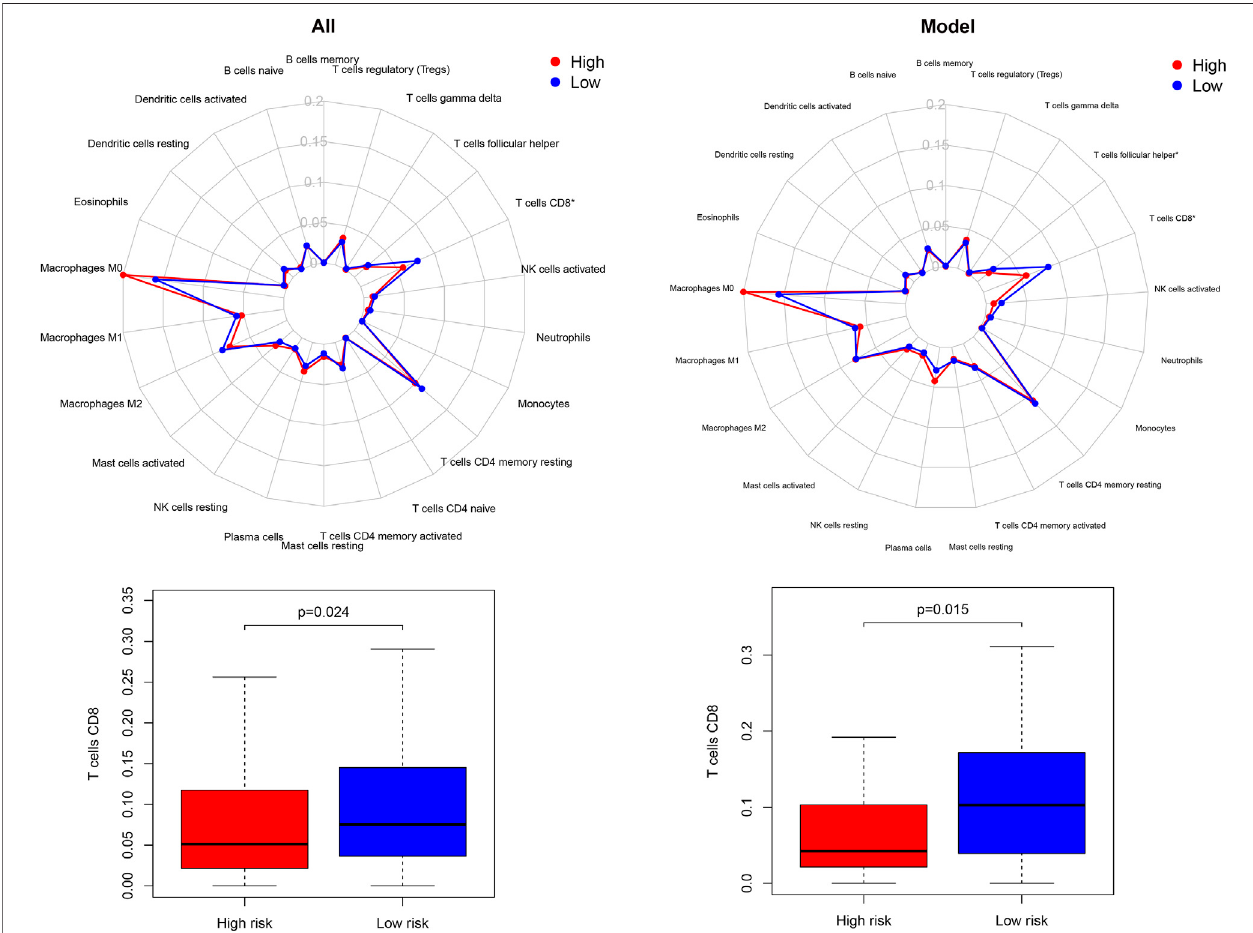
FIGURE 6 | The differences of 22 immune cell types abundance within different risk groups.